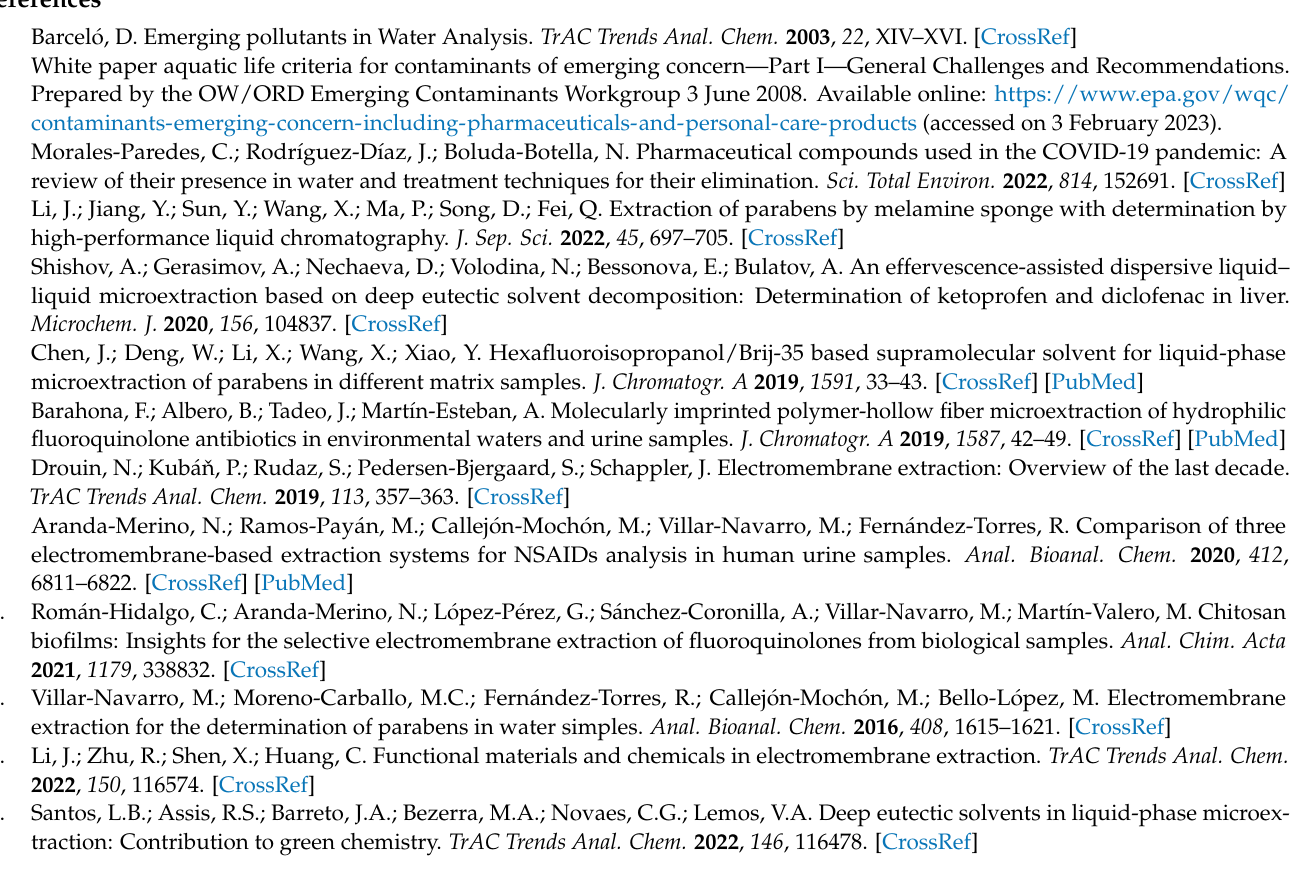
Table S2: Chemical structures and pKa values of target